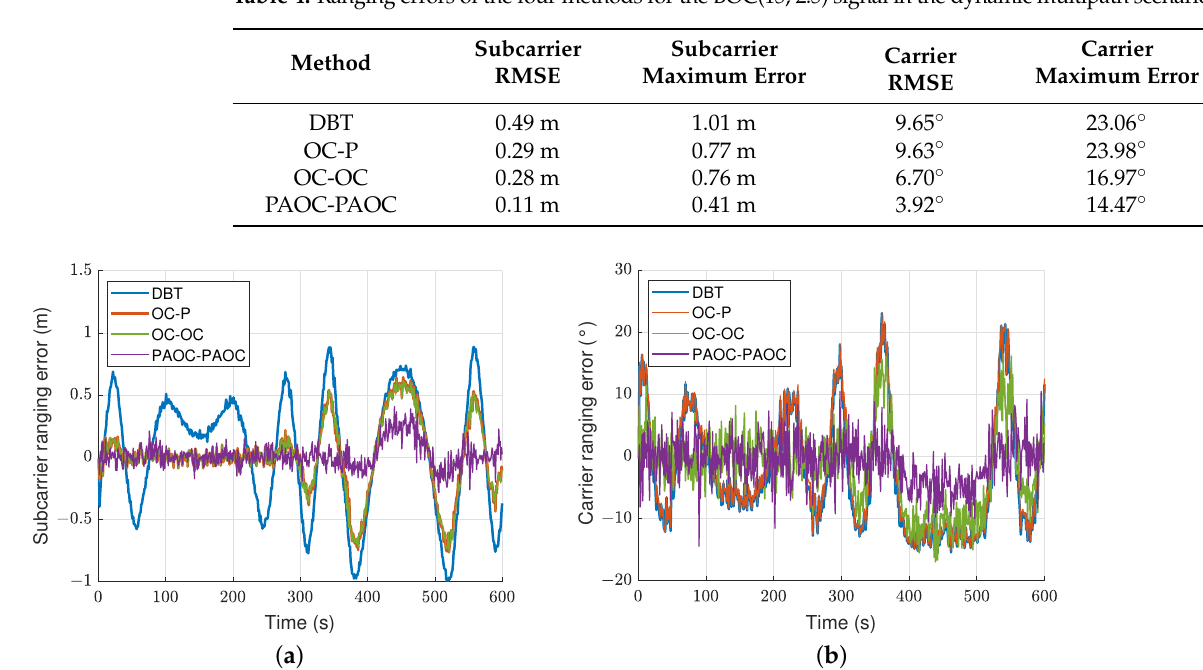
Figure 13. Ranging errors of various methods for the BOC(15, 2.5) signal in the dynamic multipath scenario: ( a ) subcarrier ranging error; ( b ) carrier ranging